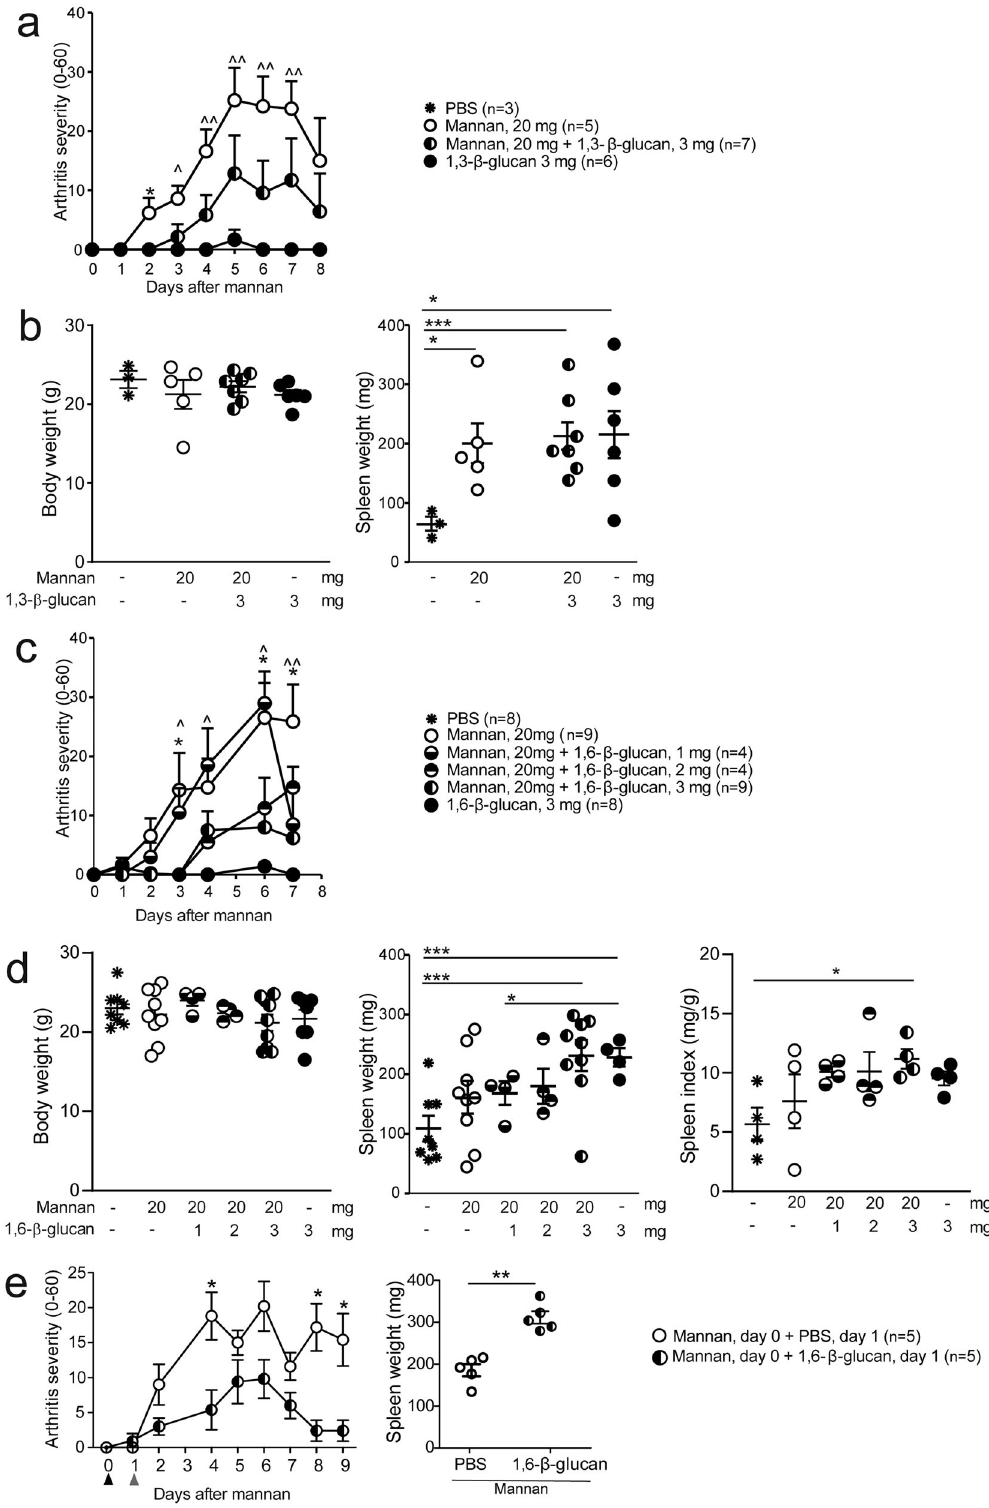
local effects on the cells in the peritoneum where it was administered. To investigate the macrophages phenotypes after exposure to mannan and/or β -glucan, peritoneal resident (CD11b + F4/80hi) and in fi ltrating (CD11b + F4/80lo) cells were measured at day 8 post injection of either mannan or mannan combined with 1,6- β -glucan. Interestingly, β -glucan lowered the percentages of resident macrophages (Fig. 5a) but increases the